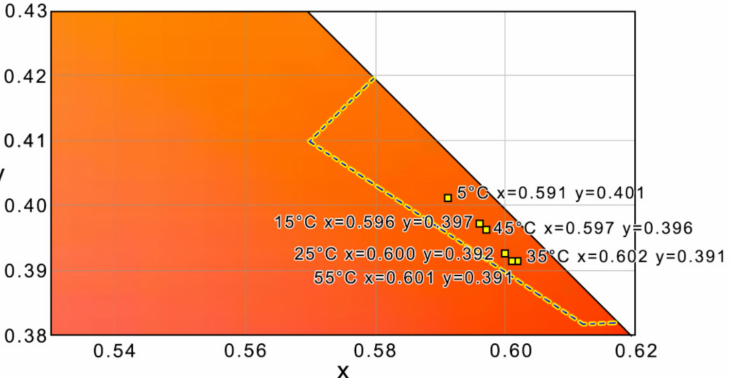
Figure 15. Compliance with the colorimetric standards of the LED: experimental